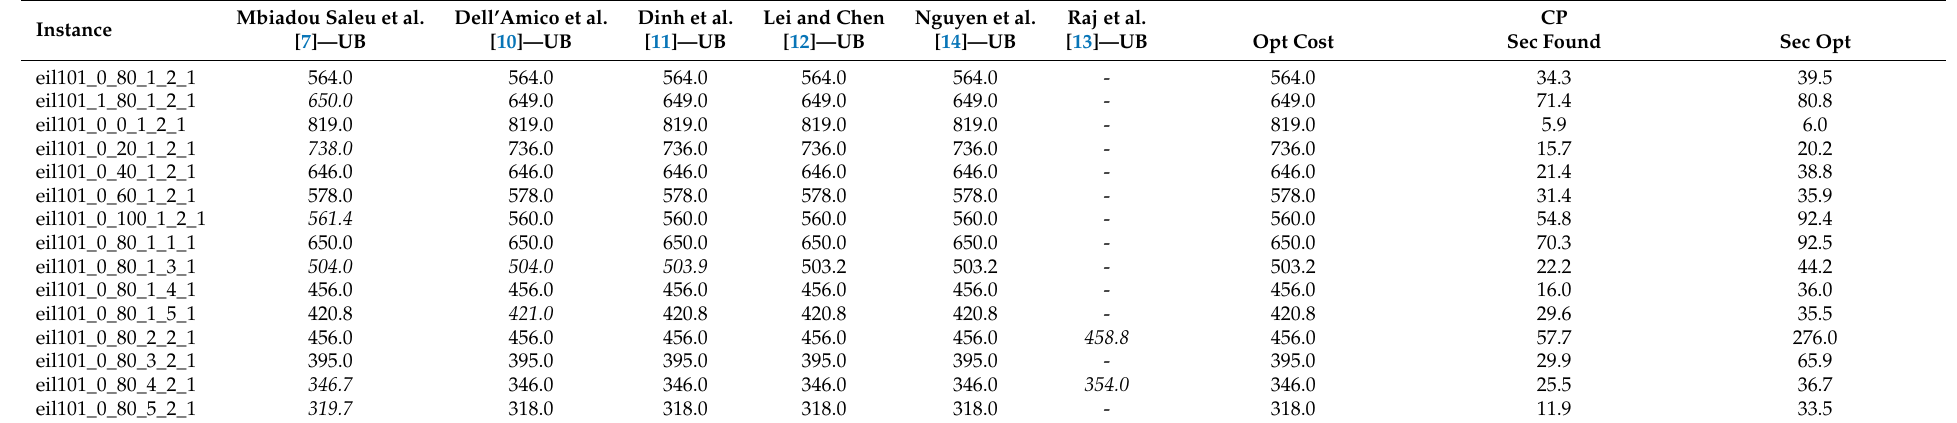
Table 4. Instances originated from eil101 in [7]. Optimal solution costs.